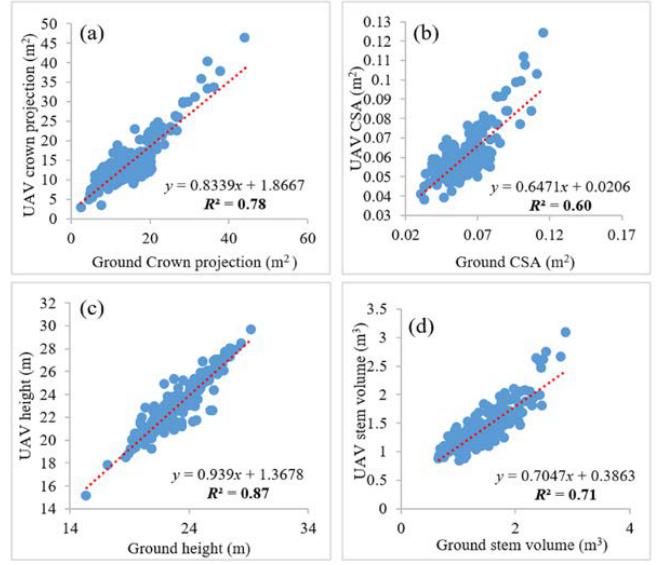
Figure 6. The correlation of ( a ) crown projection between the ground and UAV (unmanned aerial vehicle) data in m 2 ; ( b ) cross-sectional areas (CSA) between the ground and UAV data in m 2 ; ( c ) height between the ground and UAV data in m; and ( d ) stem volume between the ground and UAV data in m 3 . Table 3 . Statistical summary table, where ID represents the simplicity of identification of each tested regression; N: number of observations; RMSE: root mean square error; and df: degrees of freedom. ID represents the simplicity of identification of each tested regression.